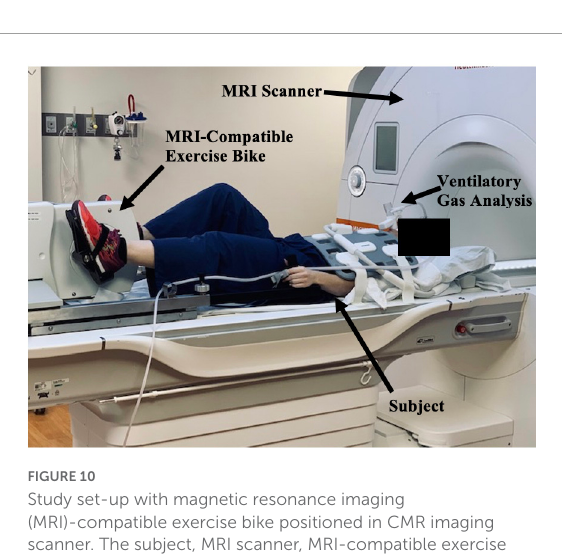
FIGURE8 Cardiovascular magnetic resonance (CMR) assessments of myocardial T1. Myocardial native T1 of control participants without cancer (965 ± 3 ms) and cancer pretreatment participants (1,058 ± 7 ms) compared with cancer survivors treated with anthracycline chemotherapy (1,040 ± 7 ms). Myocardial T1 is elevated in both cancer groups, reflecting potential myocardial fibrosis compared with cancer-free control participants ( P < 0.0001 for both). From Jordan et al. (56) with permission.